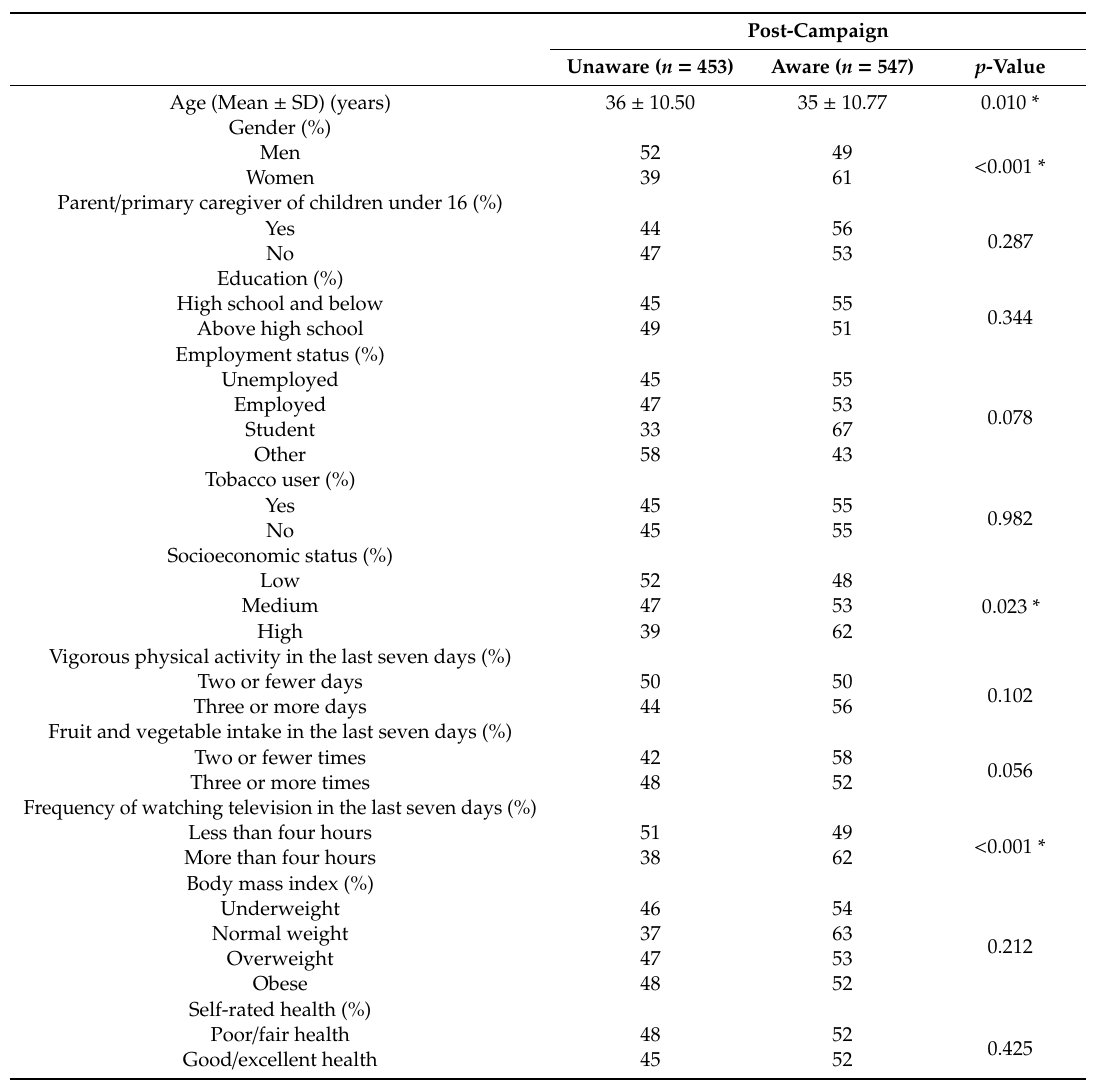
Table 2. Demographic characteristics of campaign-aware and campaign-unaware respondents in the post-campaign